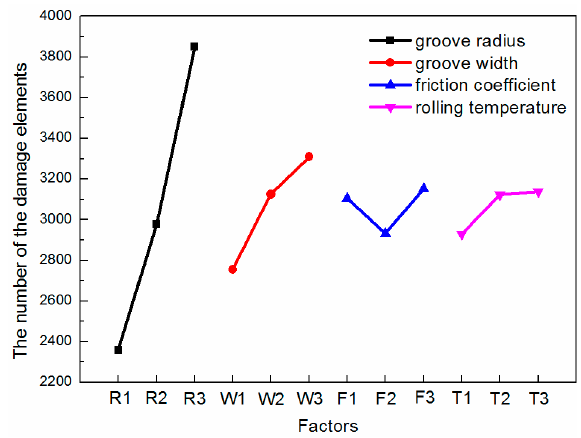
ff erent process parameters.